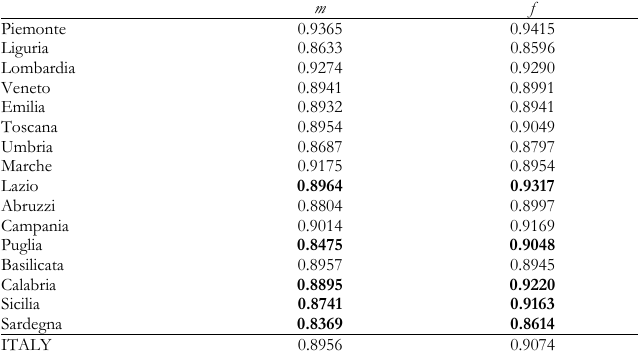
Probability of death between 80 and 90 years (by sex) in Italian regions,